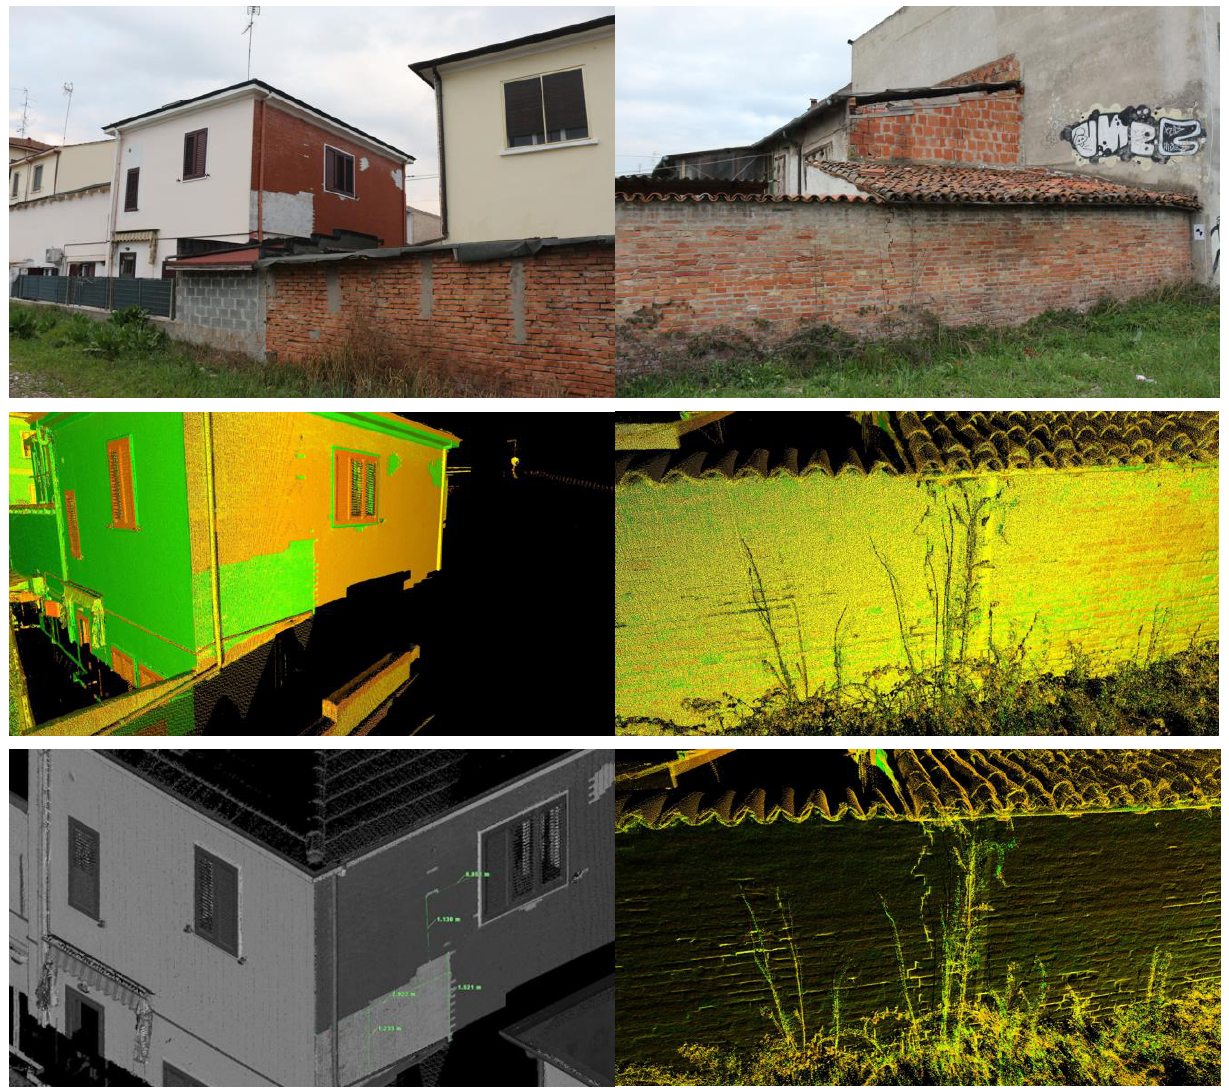
Figure 2. 3D point cloud model interrogation for detailed information: Scaled Framework for Analysis of Crack